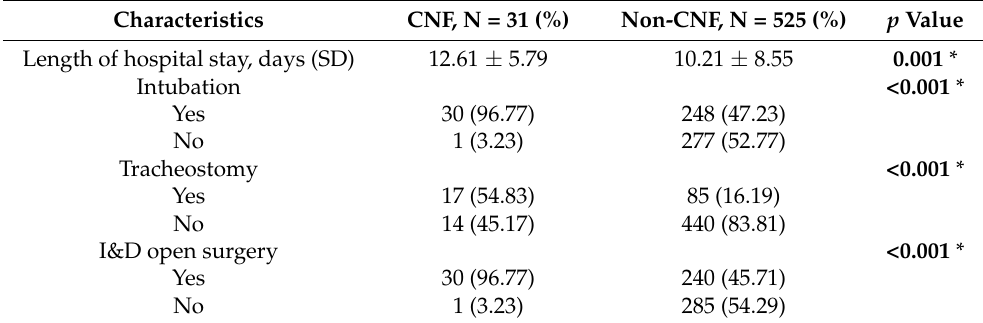
Table 3. Comparison of management and length of hospital stay between 525 patients with DNI alone compared to 31 patients with concurrent DNI and CNF.